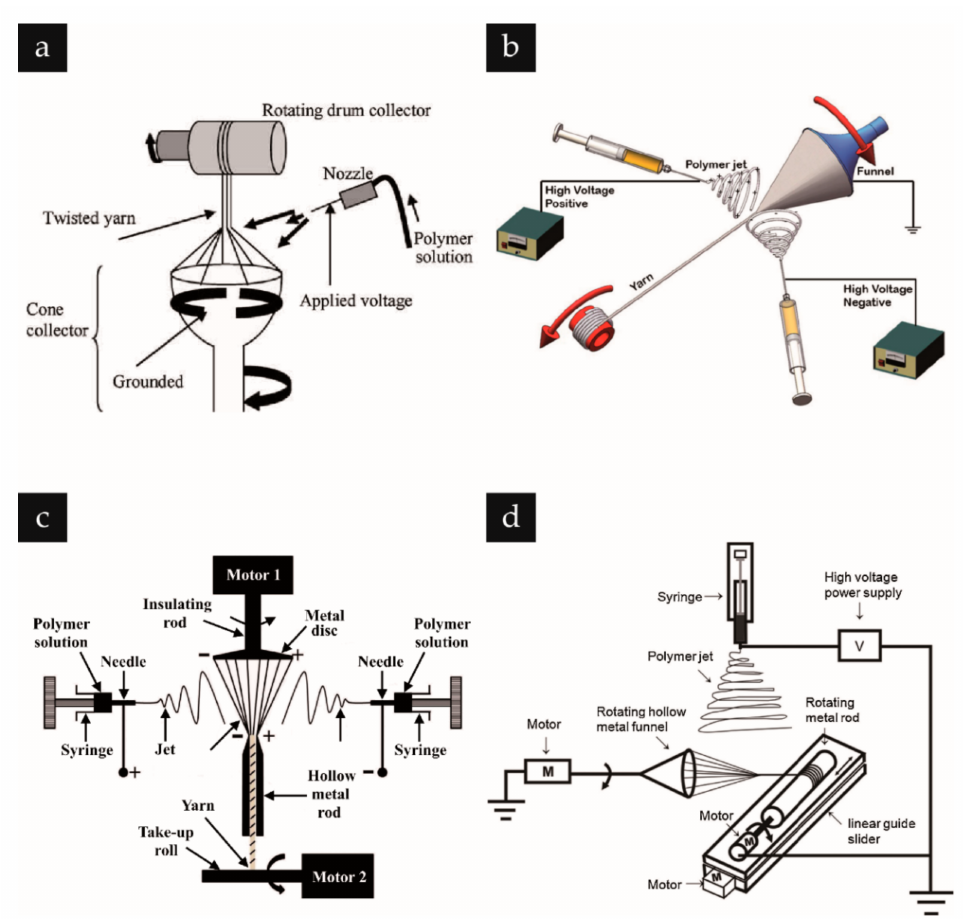
Figure 4. Variations of yarn electrospinning setups using a funnel. ( a ) The simplest variation of such setup is the one used by Afifi et al. Reprinted with permission from Ref. [27]. Copyright 2010 Wiley. ( b ) Li et al. used two nozzles, doubling the throughput and stabilizing the nonwoven cone forming on the rotating funnel. The oppositely charged nozzles made earthing the funnel no longer necessary. Reprinted with permission from Ref. [28]. Copyright 2020 American Chemical Society. ( c ) Wu et al. used a disc instead of the funnel in combination with a guiding metal rod. Reprinted with permission from Ref. [30]. Copyright 2013 Elsevier. ( d ) Yang et al. used a winder placed on a slider to distribute the yarn along the winder mandrel to produce a combination of yarns and randomly oriented fiber mat. Reprinted with permission from Ref. [38]. Copyright 2014